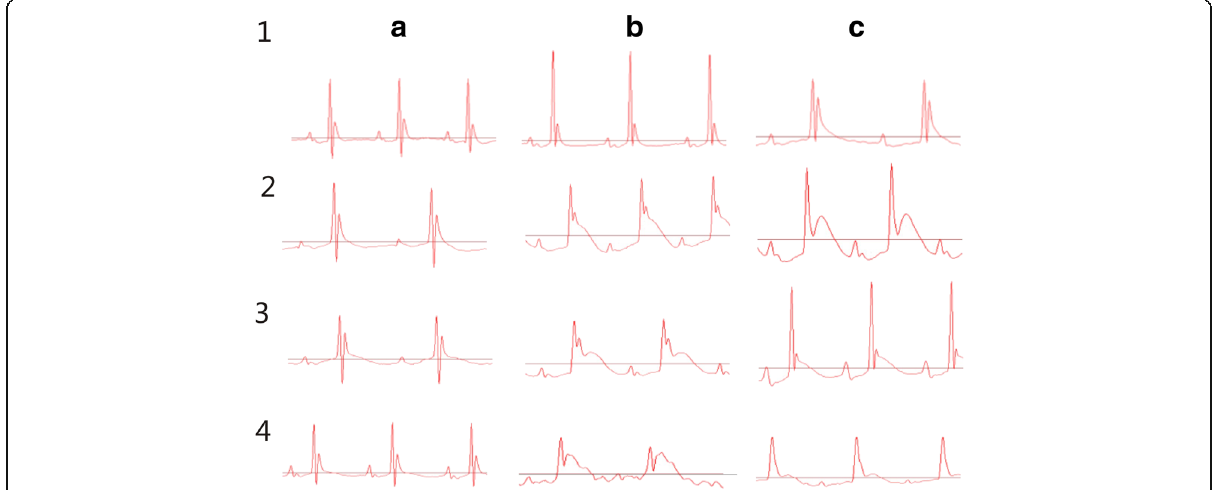
Fig. 1 Representative figures of ECG in different groups of mice. a Representative figure of pre-MI; b Representative figure of post-MI; c Representative figure of 4 wks after MI. (1) Sham group; (2) Model group; (3) XJEK group; (4) Fosinopril group